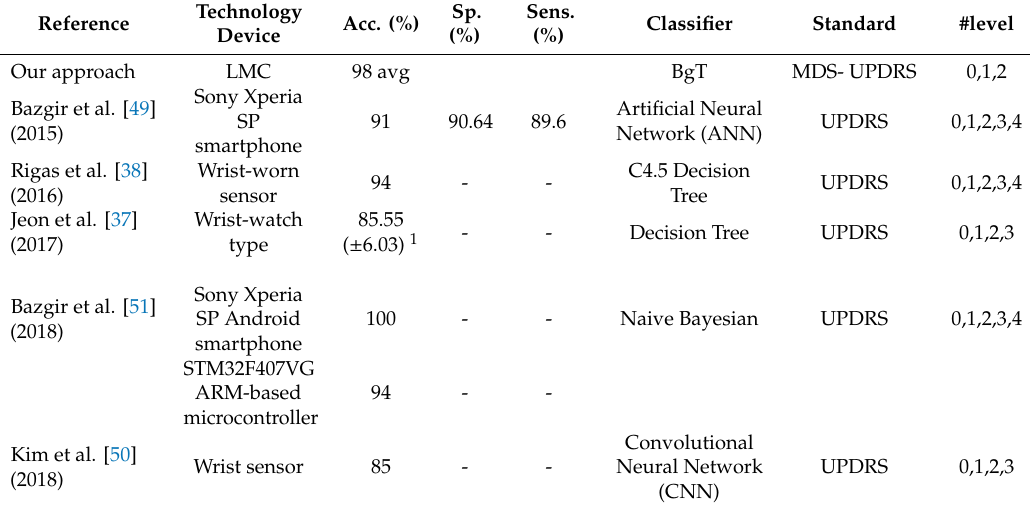
Table 5. A comparison of performance evaluation between related works and our